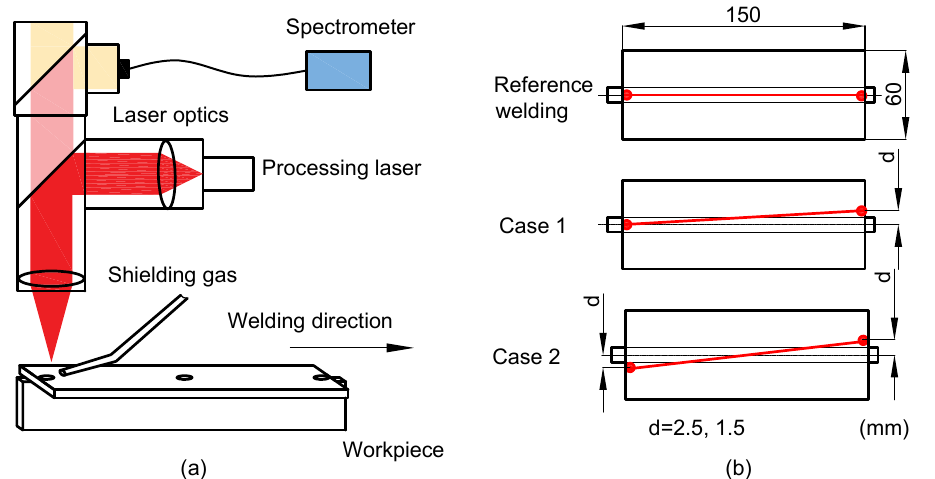
Figure 3. The welding setup and controlled beam deviations. ( a ): Welding setup; ( b ): Top-view of the joint. The red line indicates the beam path with controlled deviation.